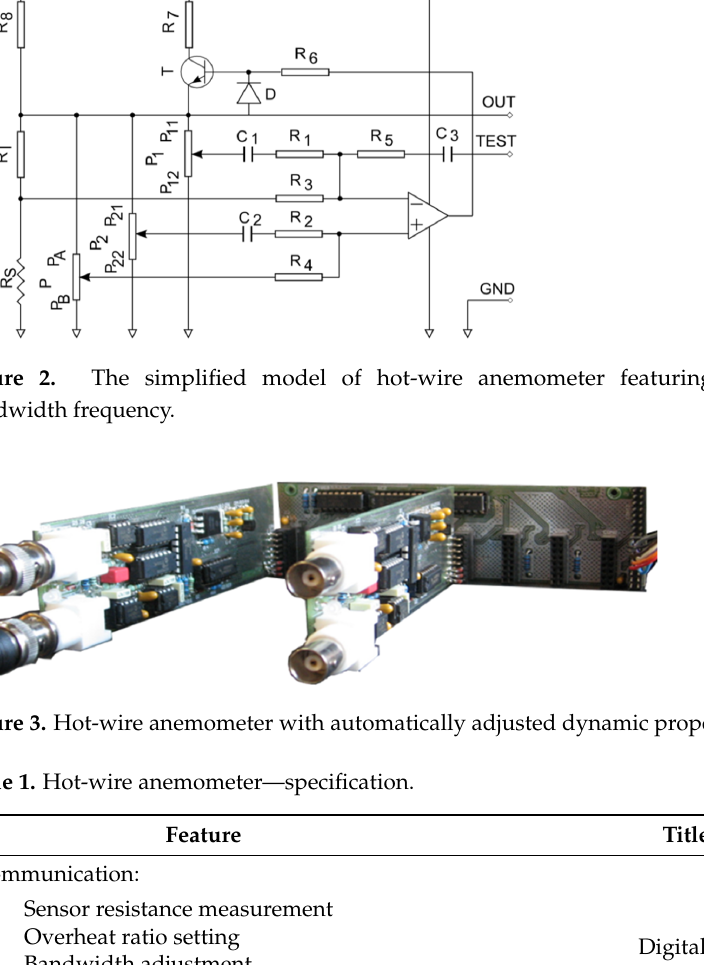
Figure 2. The simplified model of hot-wire anemometer featuring the optimization of bandwidth frequency.